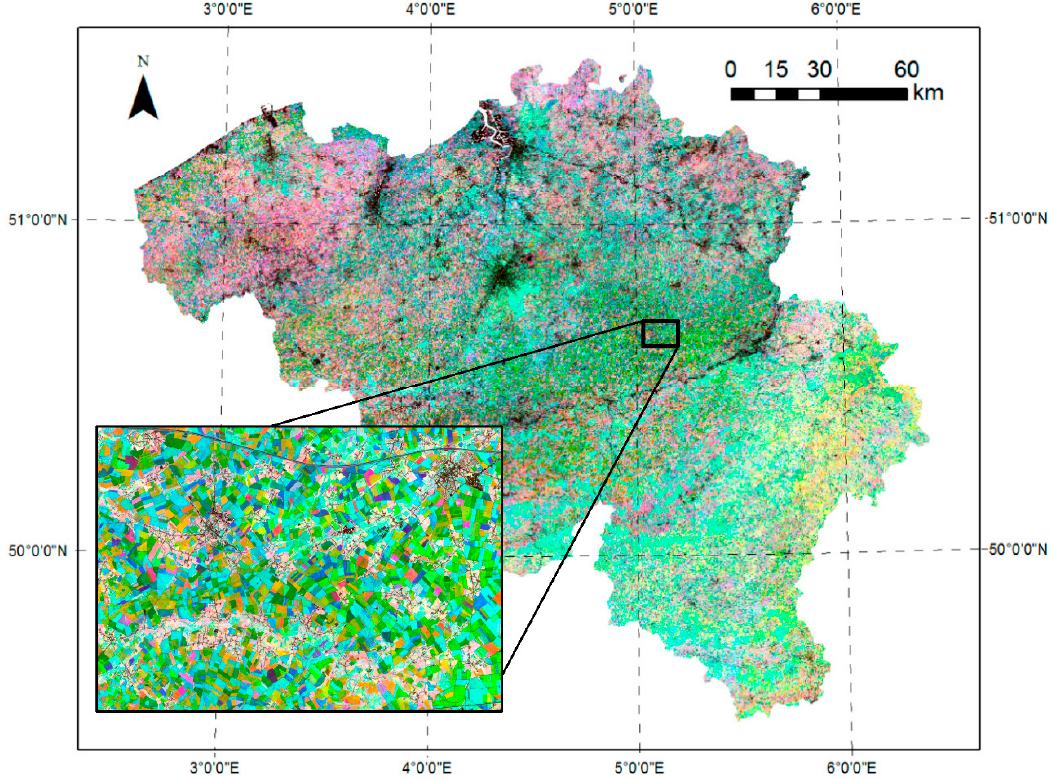
Figure 3. RGB composite of smoothed NDVI. First 10-day period of March 2017 (red), last 10-day period of June 2017 (green), and last 10-day period of August 2017 (blue). Inset shows a detailed view of this RGB, demonstrating the differences in temporal NDVI mosaics across different agricultural parcels.